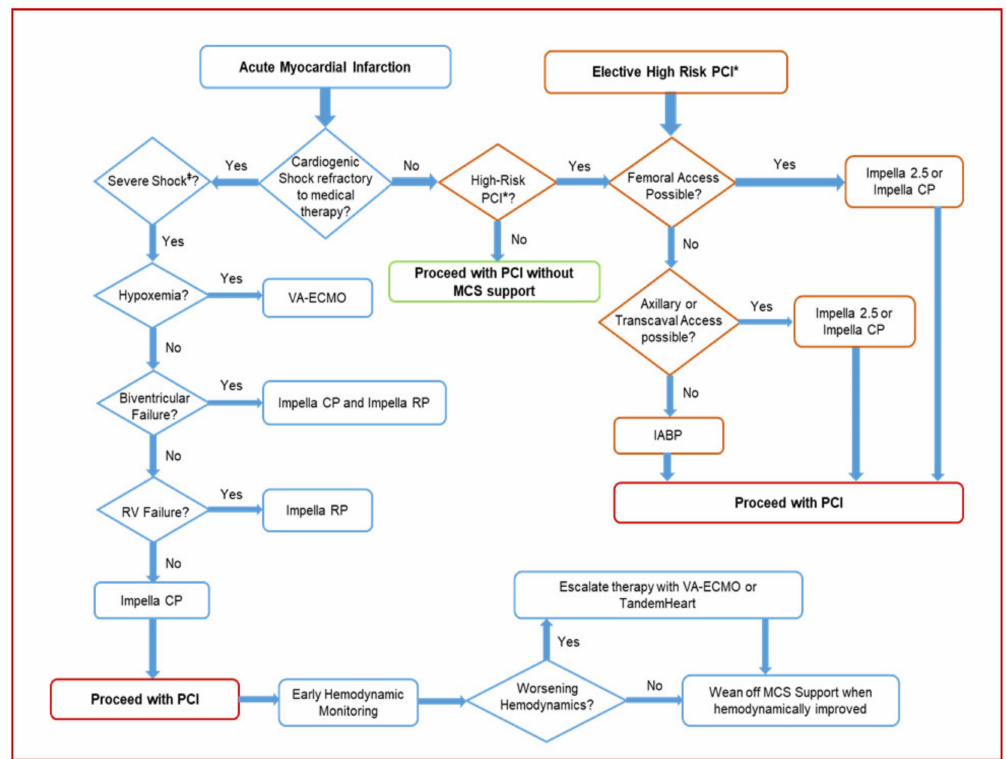
Figure 2. Suggested algorithmic approach for MCS in patients with cardiogenic shock complicating AMI and high-risk PCI. MCS, mechanical circulatory support; AMI, acute myocardial infarction; PCI, percutaneous coronary intervention. IABP, intraaortic balloon bump; VA-ECMO, venoarterial extracorporeal membrane oxygenation. * High-risk PCI is defined as presented in Table 1 and mainly include comorbidities, severe LV dysfunction (EF < 35%), and complex coronary artery disease involving a large territory, such as unprotected left main, sole-remaining vessel, or three-vessel disease. ‡ Severe cardiogenic shock is defined as markedly abnormal hemodynamic parameters (systolic blood pressure < 90 mmHg, heart rate > 120 beats per minute, cardiac index < 1.5 L / min / m 2 , pulmonary capillary wedge pressure / left ventricular end-diastolic pressure > 30 mmHg), metabolic (lactate > 4 mg / dL), and clinical (confusion, cool extremities, on ≥ 2 vasopressors / inotropes)